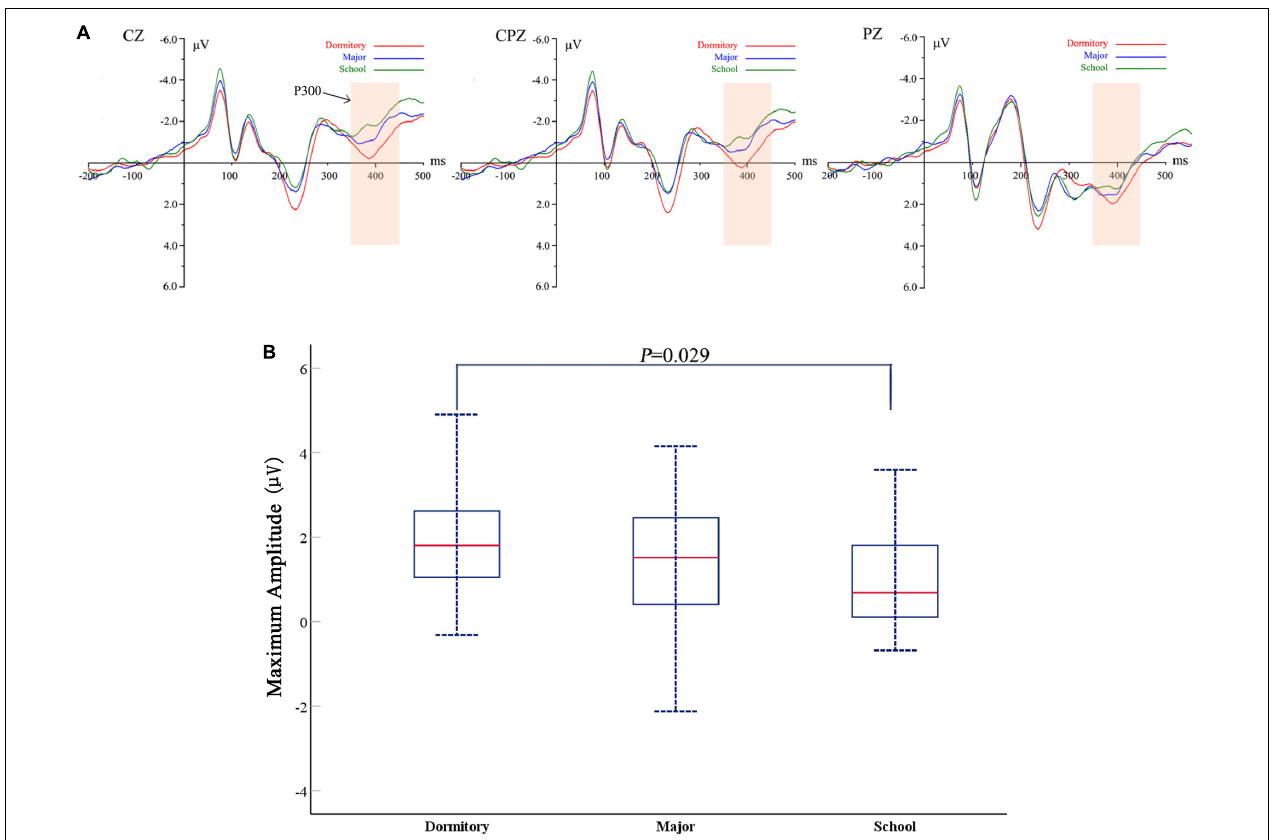
FIGURE 4 | (A) Grand averaged ERPs waveforms at CZ, CPZ, and PZ of social distances in Task 2. (B) ANOVA results of social distances in Task